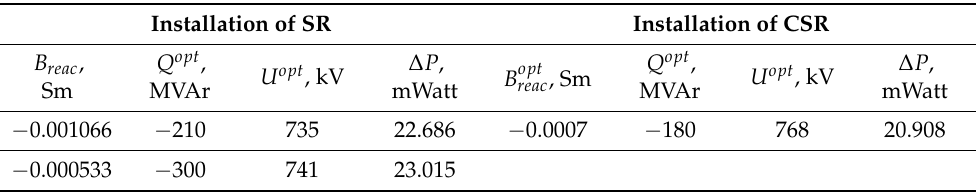
Table 7. Results of parametric optimization when using CSR and SR for ideal transposed extra-high voltage power line.